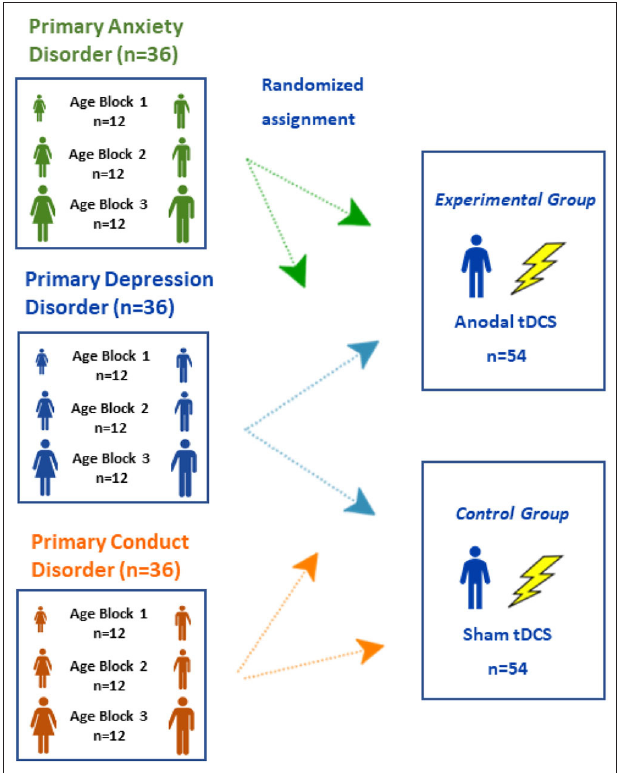
FIGURE 1 | Overview of stratification and randomization of clinical groups.